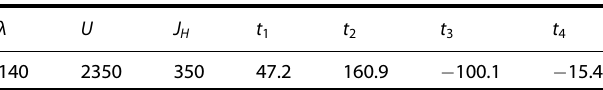
Table 2. Physical parameters for numerical calculations in a unit of